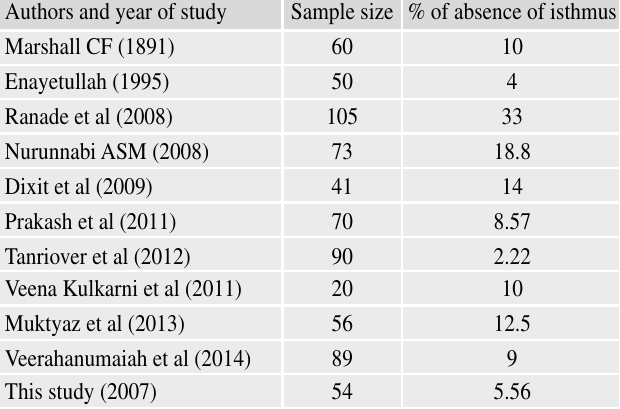
Table IV: Comparison of absence of isthmus in